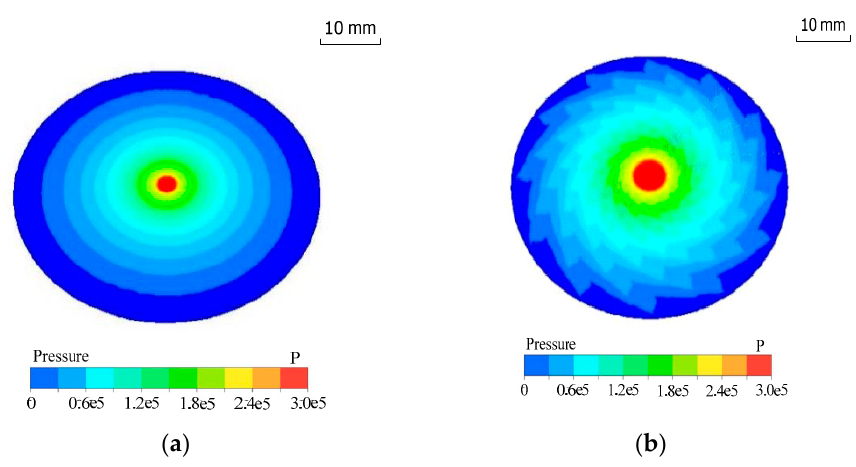
Figure 3. Pressure field of slurry film in the horizontal section. The fluid film thickness of the computational fluid dynamics (CFD) model is 100 μ m, the pressure of the slurry inlet is 0.3 MPa and the rotational speed of disc polishing is 3000 rpm. ( a ) Without groove, ( b ) with grooves.